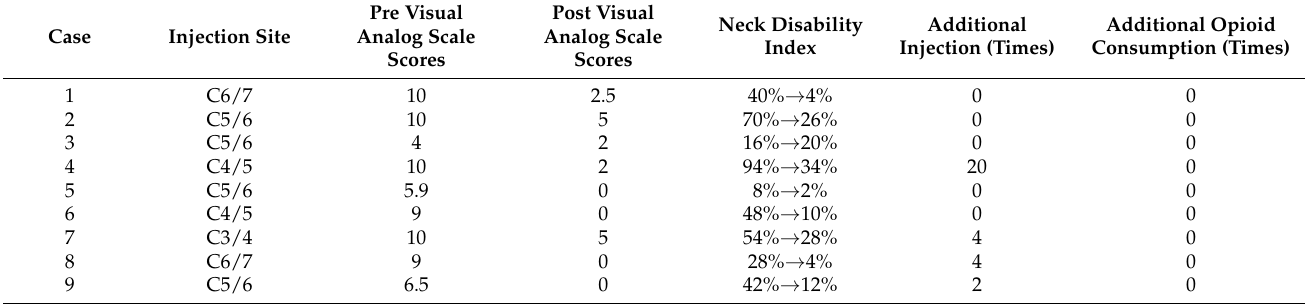
Table 2. Pain intensity and functional ability before and after ultrasound-guided epidural